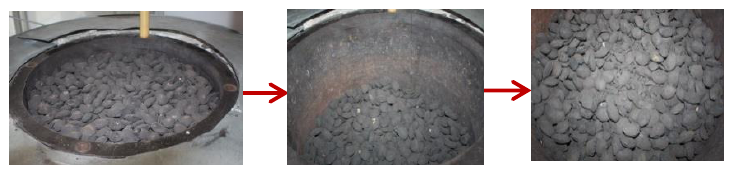
Figure 13. UCT results of sintered slag pebbles.